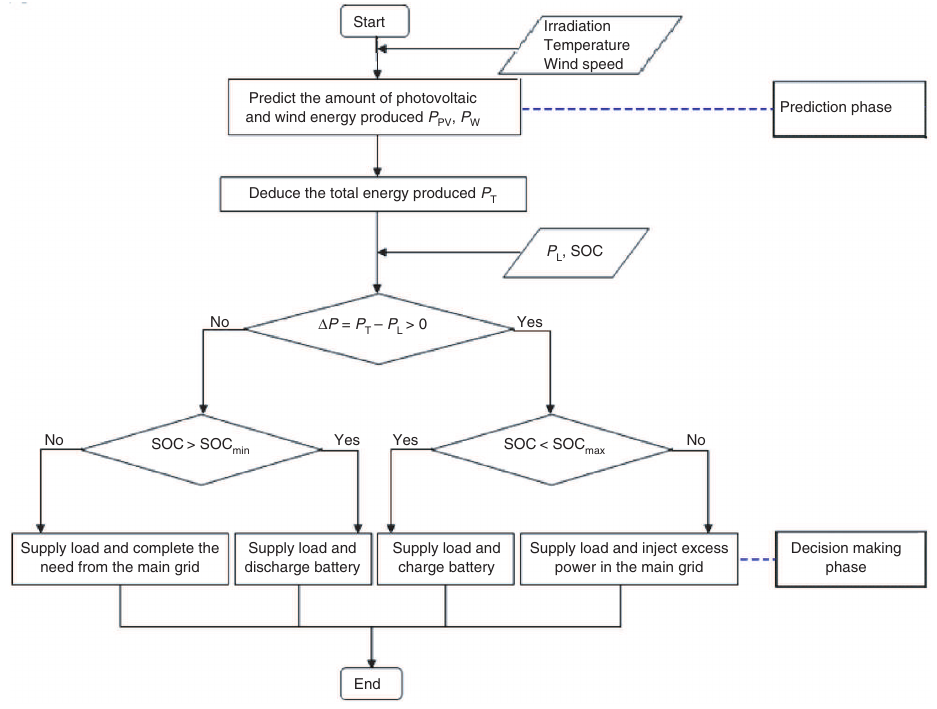
Figure 7: Proposed Flowchart Representing the